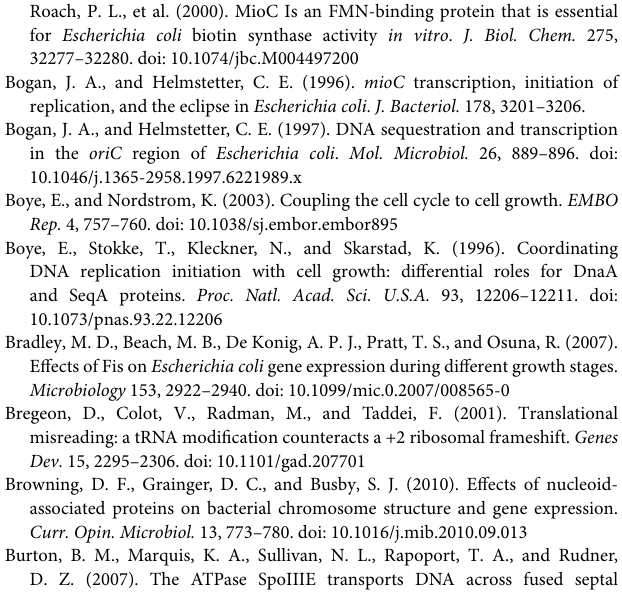
Figure S1 | Growth phase-specific cell elongation in PmioC PgidA fis. Cell length (open circles) and culture density (OD600, dashed line) were measured in PmioC PgidA fis triple mutant cells for 10h after 1:1600 dilution into fresh LB medium. Maximal cell length occurs in mid-late exponential phase, with cells approaching normal cell length by late stationary phase. Table S1 | E. coli strains. Table S2 | Cloning primers. Table S3 | Functional categorization of GidA and MioC regulated